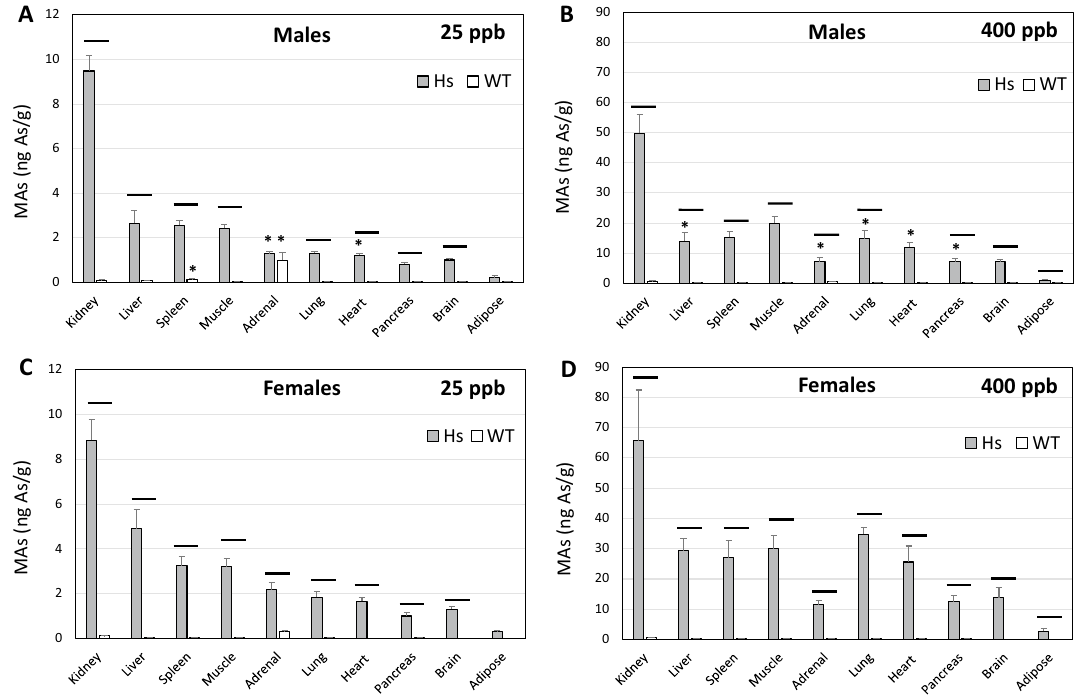
Figure 4. Concentrations of MAs in tissues of humanized (Hs) and wild-type (WT) male and female mice after 4-week exposure to 25-ppb ( A , C ) or 400-ppb ( B , D ) of inorganic arsenic in drinking water. Each bar and whisker represent mean and SEM value, respectively. For 25-ppb exposure, N = 6 for Hs males and WT males, and N = 8 for Hs females and WT females. For 400-ppb exposure, N = 7 and 8 for Hs males and WT males, respectively, and N = 10 and 11 for Hs females and WT females, respectively. Horizontal line marks significant difference between genotypes for individual tissue; asterisk marks significant difference between males and females of the same genotype (p <